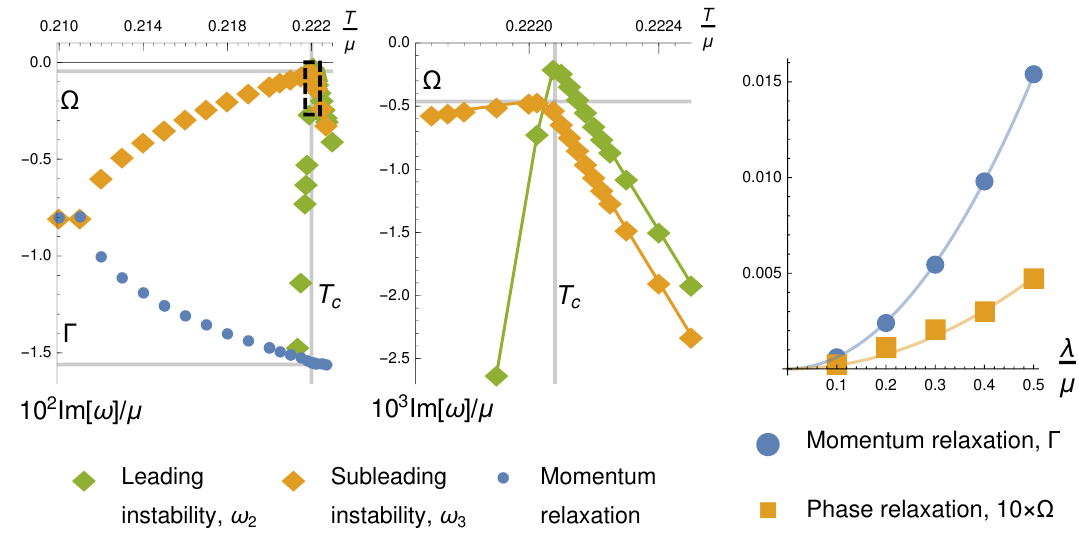
Figure 8. Left panels. The spectrum of purely imaginary quasinormal modes of the helical holographic model in vicinity of the critical temperature. The general behavior closely parallels that of figures 2, 3. Three modes above T : momentum relaxation, leading instability, which drives c the phase transition, and subleading instability, which turns into a damped Goldstone below T . c The momentum relaxation and damped Goldstone modes become coupled below T and recombine c forming the pseudo-Goldstone at lower temperature. Note that, unlike figure 3, here Γ (cid:29) Ω . The data is for λ = 0 . 5 µ, p = 2 . 16 µ . The second plot zooms into the dashed region of the first one. c Right panel. Dependence of the phase relaxation rate Ω and momentum relaxation rate Γ on the scale of explicit symmetry breaking λ in helical model. Both behave